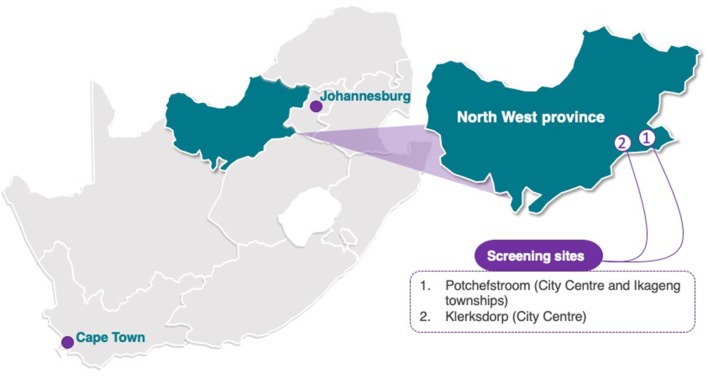
Data and sample collection for the ExAMIN Youth SA study took place in Potchefstroom and surrounding areas as well as in Klerksdorp, both located in the Southern district of the North-West province of South Africa. The outline of the South African map was purchased from yourfreetemplates.com with the Creative Commons' license, which is Attribution-NoDerivatives 4.0 International (CC BY-ND 4.0).